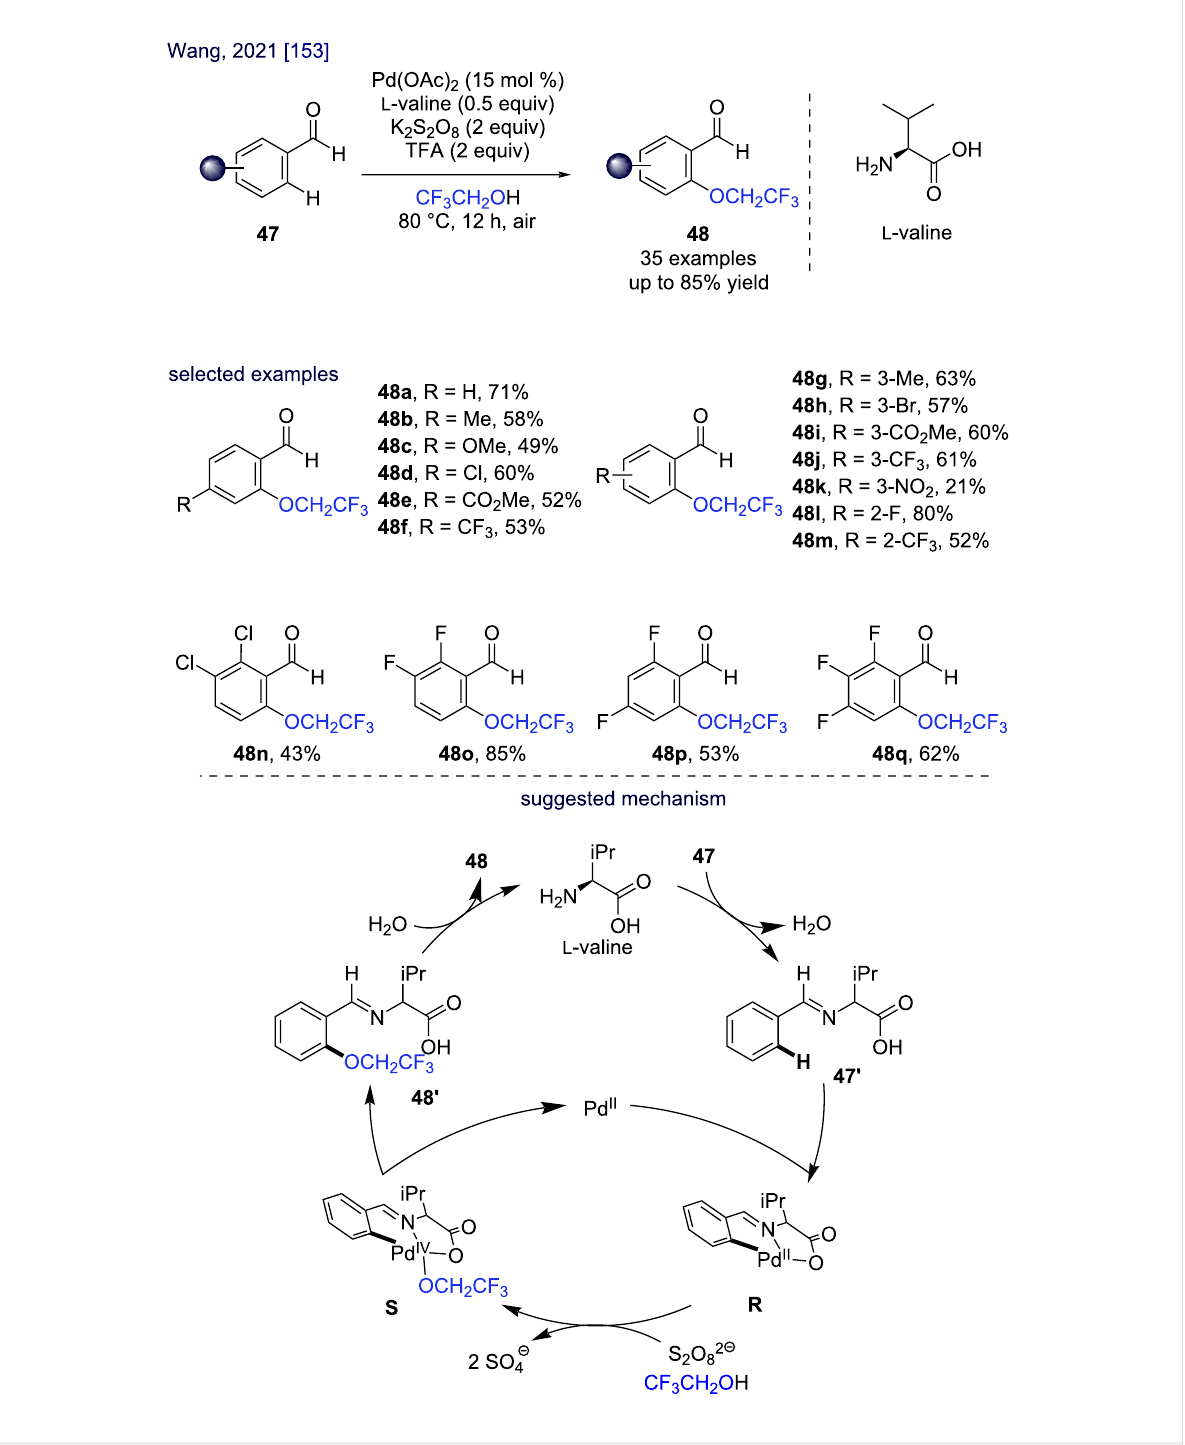
Scheme 22: Pd(II)-catalyzed selective ortho -2,2,2-trifluoroethoxylation of benzaldehyde derivatives by means of the transient directing group strategy as reported by the group of Wang [153].